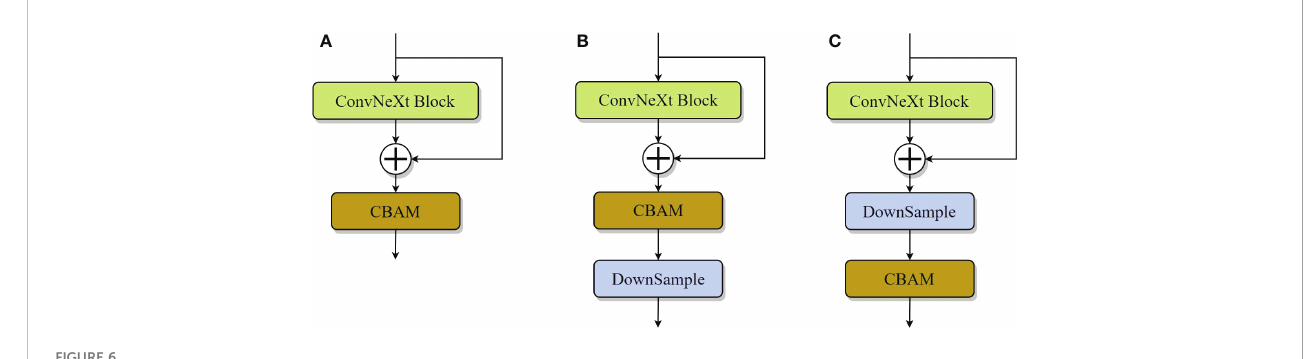
FIGURE 6 CBAM embedded position design.